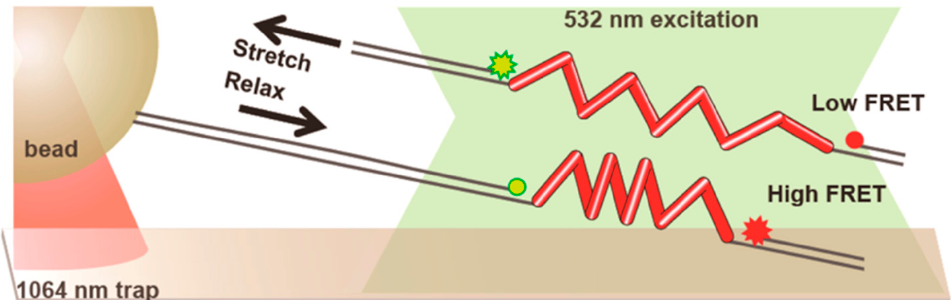
Figure 6. Combination of optical trapping and Förster resonance energy transfer (FRET) in the experimental setup devised by Brenner et al. [95]. The end-to-end extension of the repeat protein made of spider silk peptides is measured by FRET, while optical tweezers are used to apply forces. Trapping laser and fluorescence excitation are kept well apart by long double-stranded DNA (dsDNA) handles. Reprinted with permission from [95]. Copyright 2016 American Chemical Society.